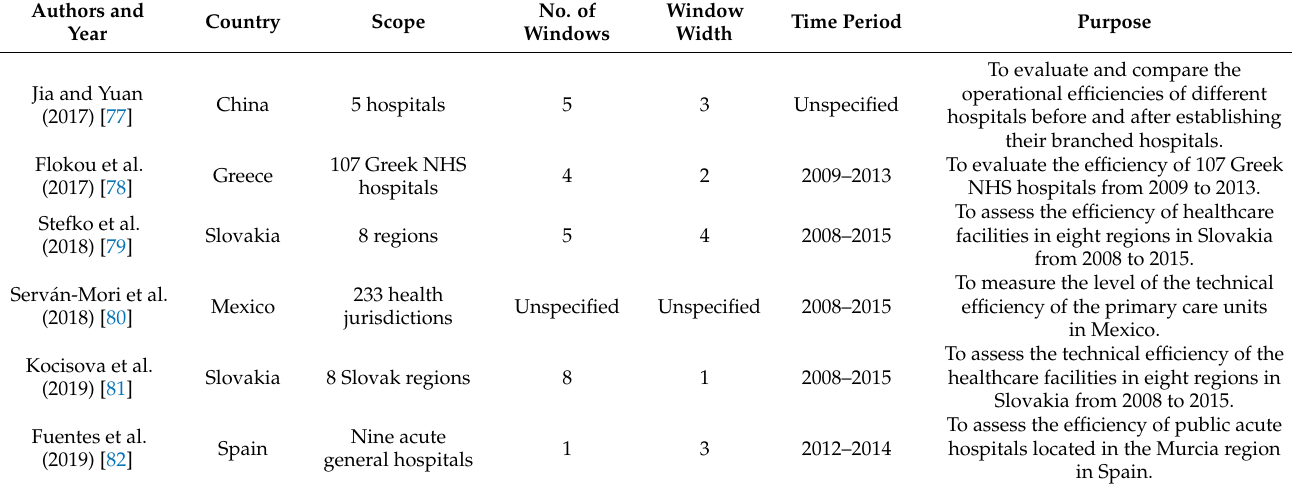
Table 8. Articles classified under the healthcare category.